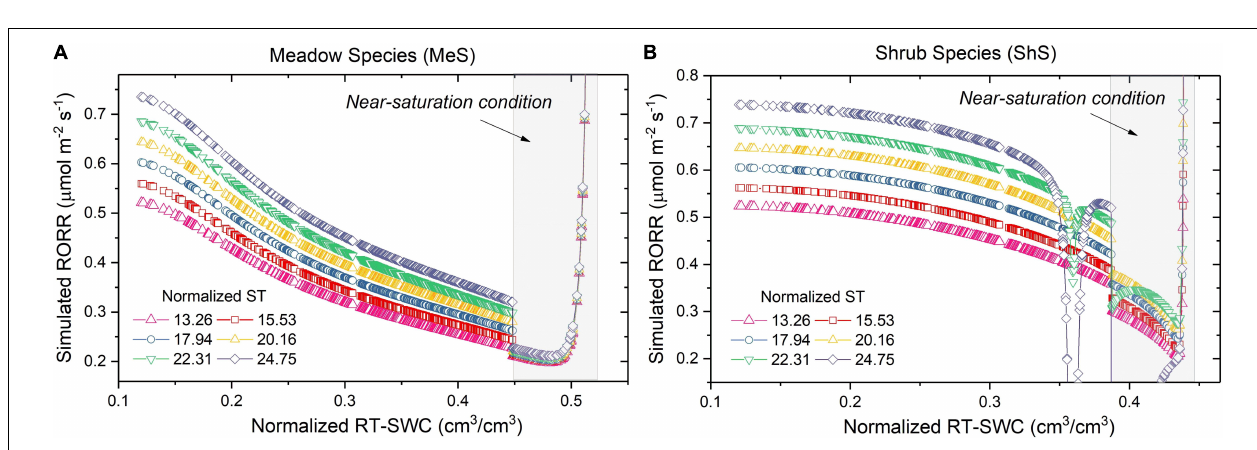
FIGURE 6 | Sensitivity of the RORRs to RZ-SWCs at various ST (ranging from 13.26 to 24.75 ◦ C) for the MeS (A) and ShS (B) . Gray areas indicates the near-saturation conditions.